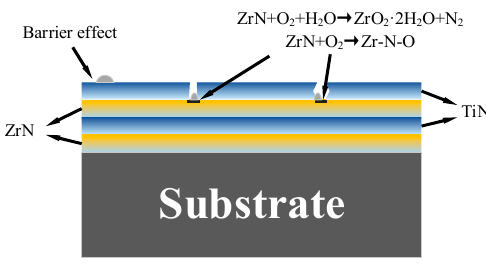
Figure 10. Schematic diagram of the corrosion process of TiN/ZrN coating in salt spray environment.